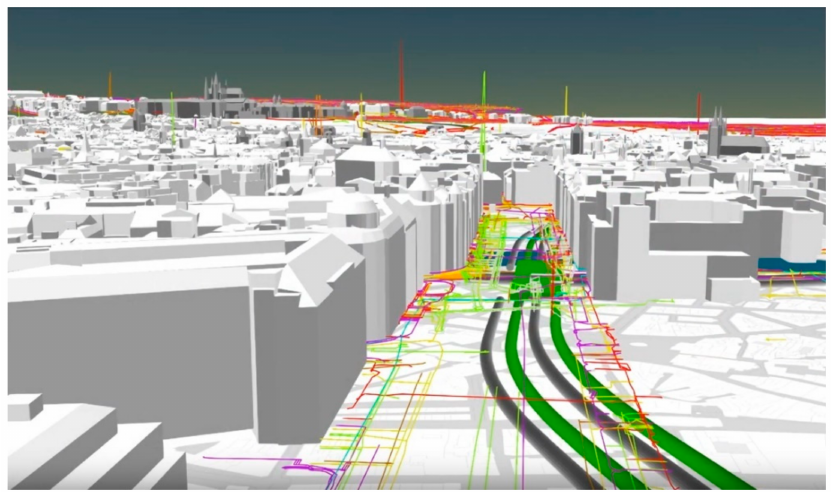
Figure 3. The 3D model of Prague and 3D networks of technical infrastructure; Source: